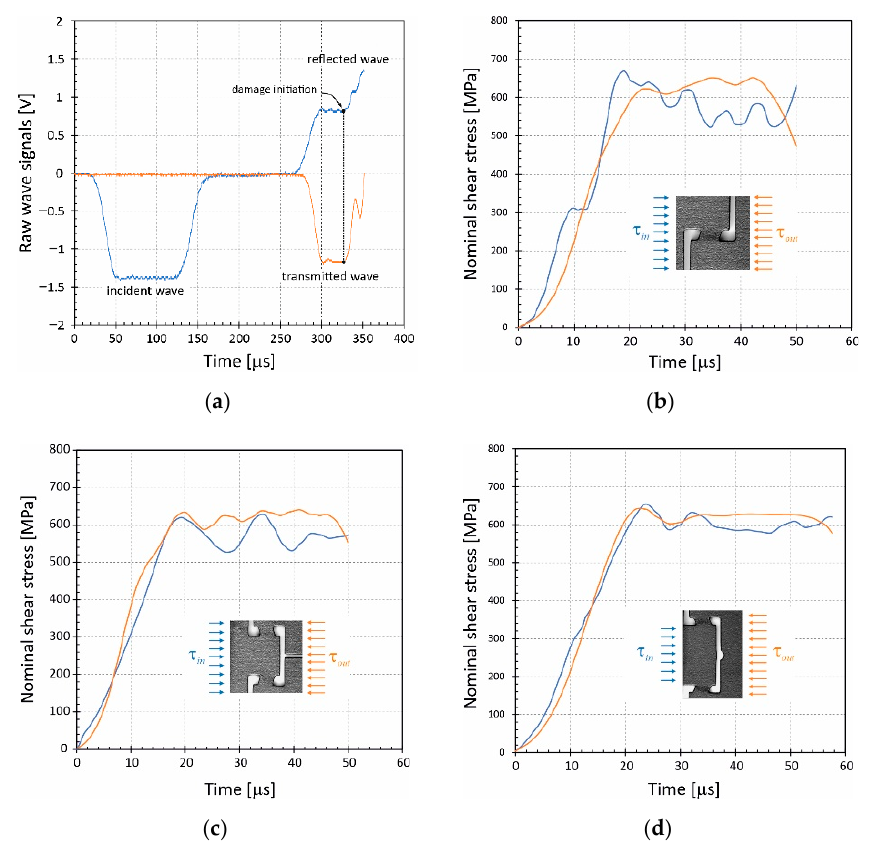
Figure 6. ( a ) Typical raw wave signals of D2S specimen recorded by the SHPB technique, equilibrium stress state at specimens: ( b ) SSS; ( c ) DSS; ( d ) D2S.